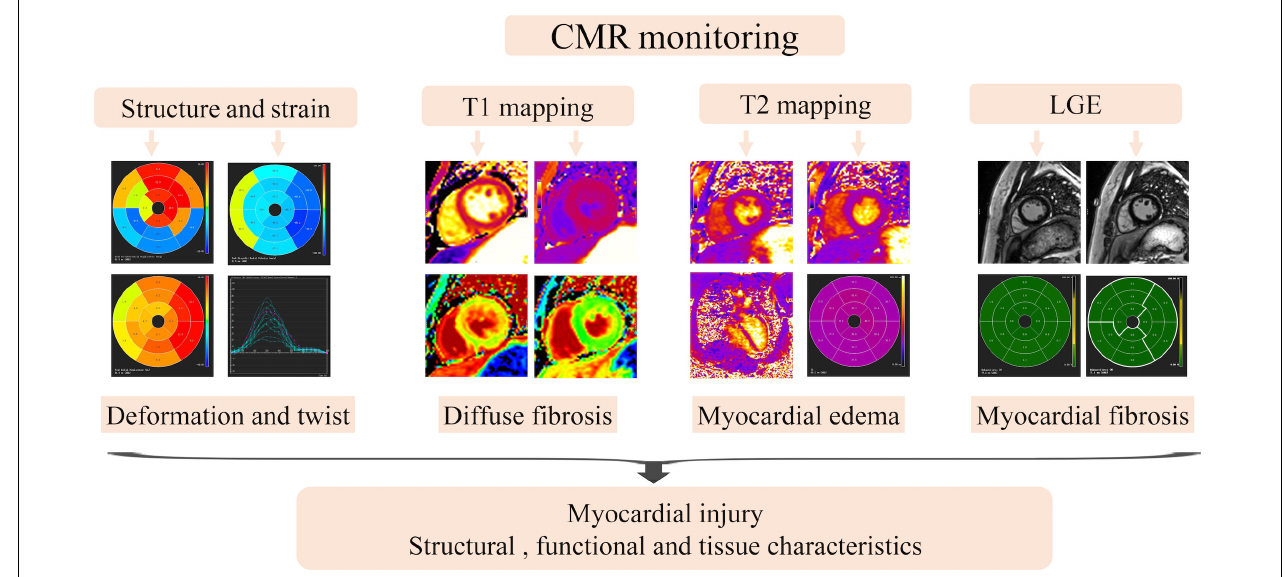
FIGURE 2 | The monitoring of myocardial injury by multi-parameter of cardiac magnetic